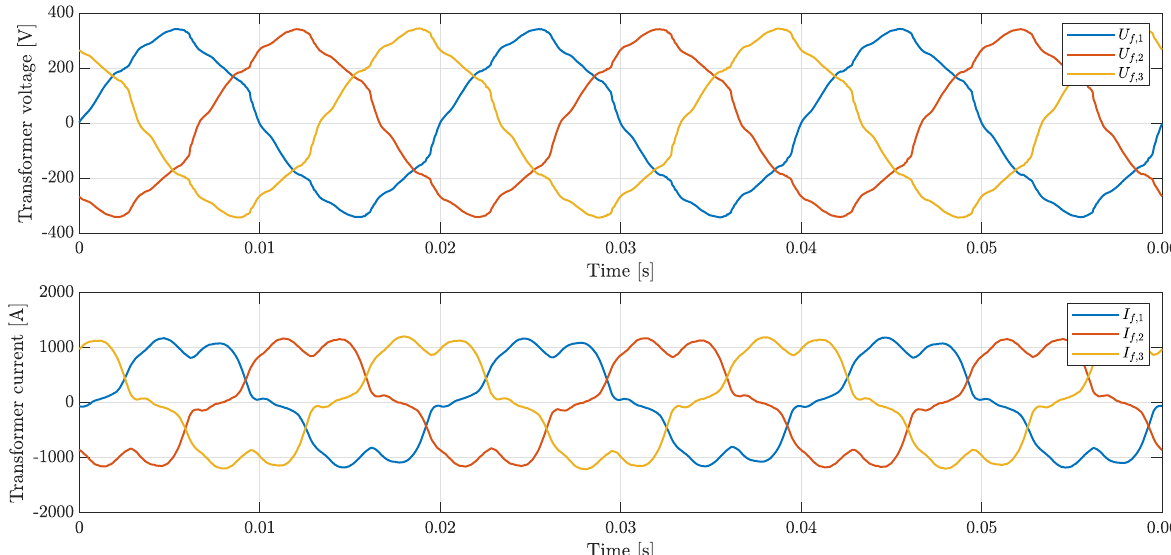
Figure 13. C2—Secondary voltage and current of transformer T1 before switching on the capacitor stage.